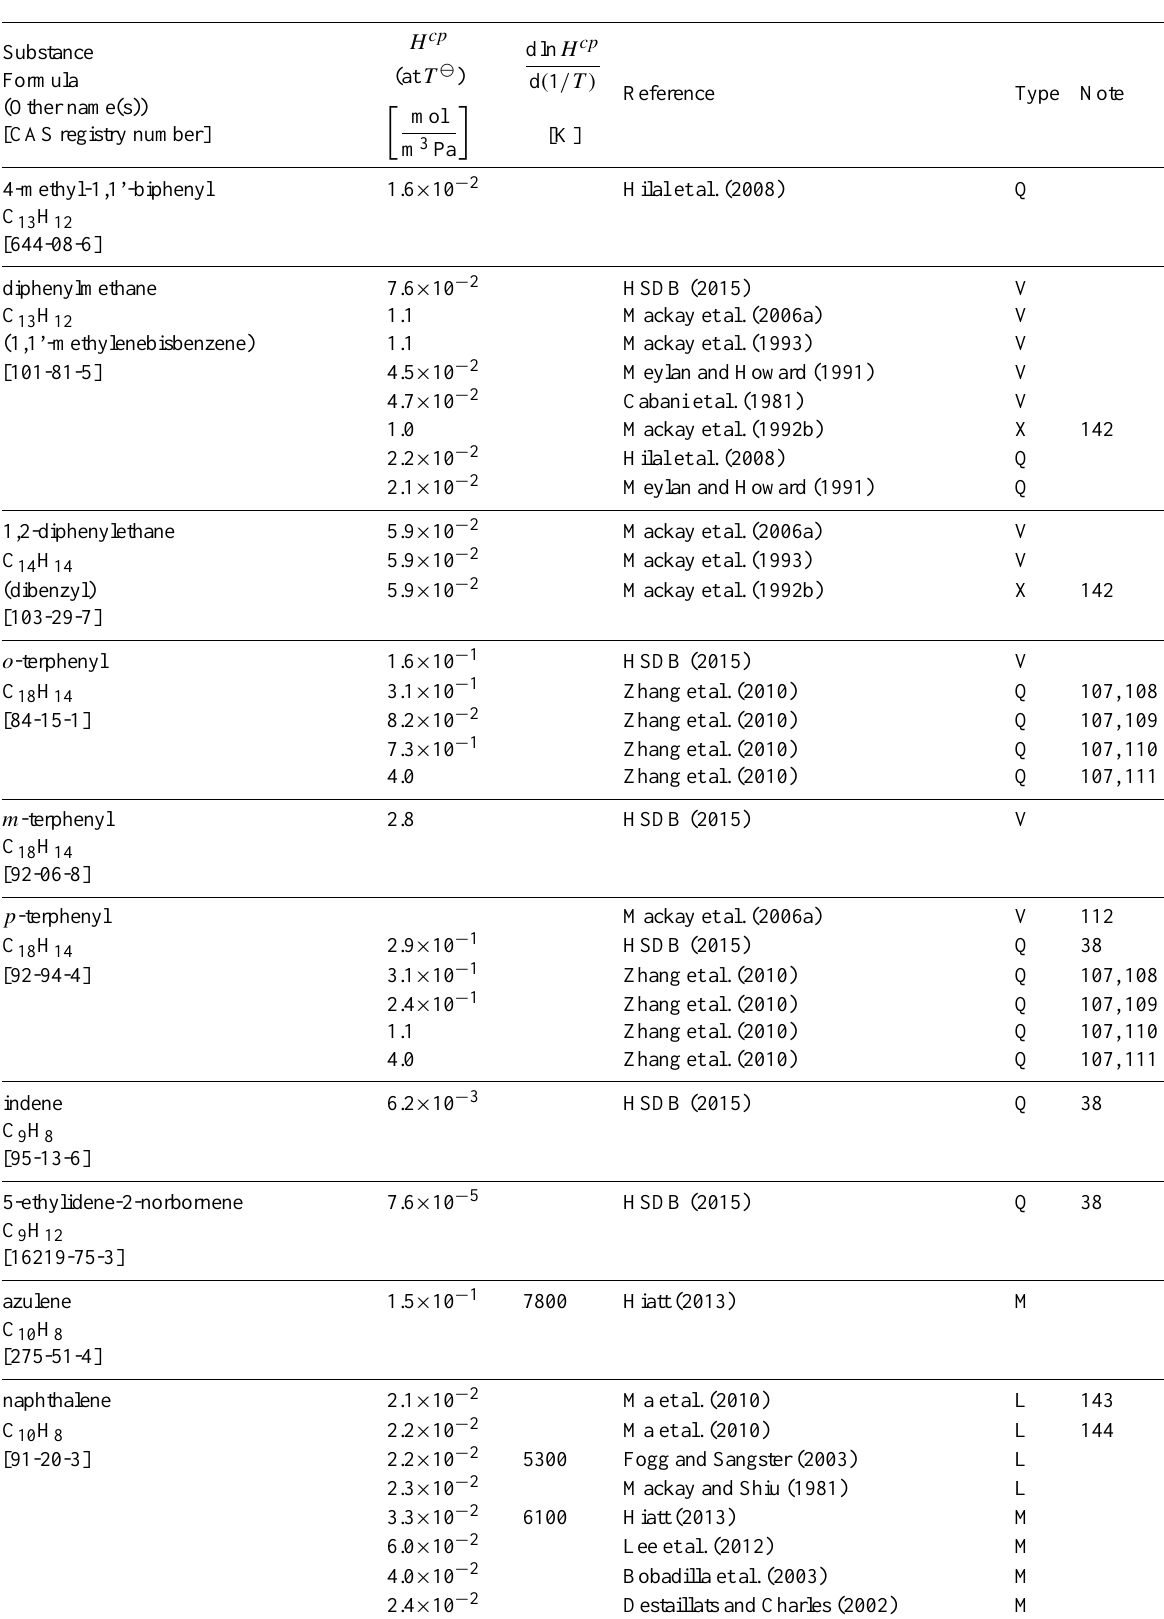
Table 6: Henry’s law constants for water as solvent